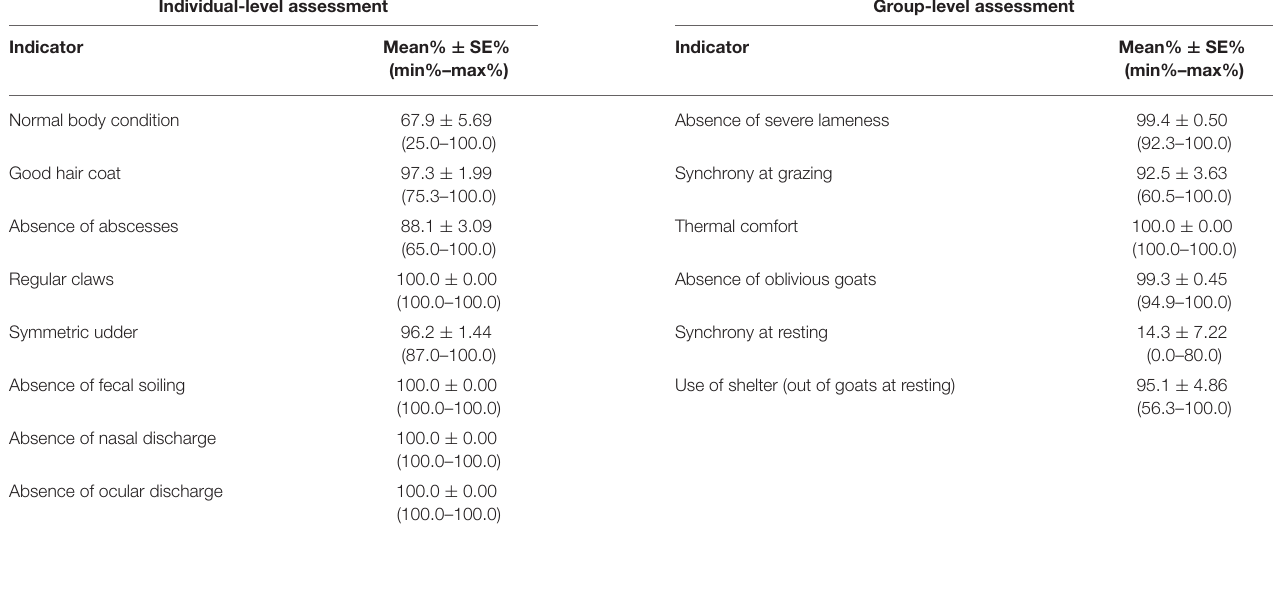
TABLE 2 | Absence of welfare problems (mean ± SE; min–max) observed in 13 semi-extensive dairy goat farms, recorded during individual- and group-level assessment.